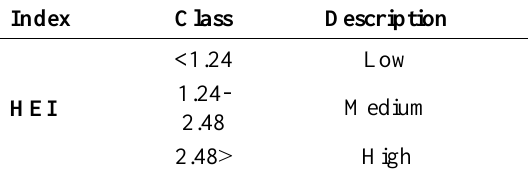
Table 2 Classification of Silakhor River water quality based on modified categories for HEI